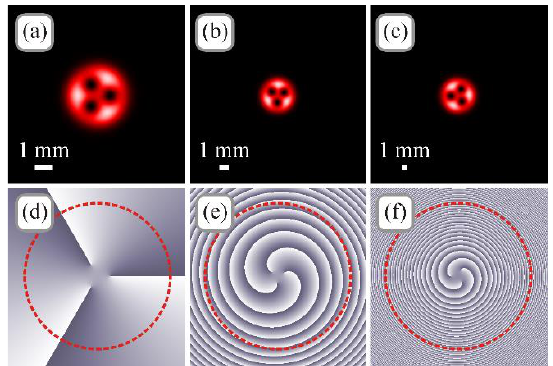
Figure 3. Intensity ( a – c ) and phase ( d – f ) distributions of a Gaussian beam with several vortices (Equation (19)) in several transverse planes for the following parameters: wavelength λ = 633 nm, waist radius w = 1 mm, number of vortices m = 3, radius of the circle with vortices r 0 = 0.7 w , propagation distances z = 0 ( a , d ), z = z 0 /2 ( b , e ), and z = 2 z 0 ( c , f ), calculation area − R ≤ x , y ≤ R with R = 5 mm ( a , d ), R = 10 mm ( b , e ), and R = 20 mm ( c , f ). Red circles on the phase distributions are those along which TC (Equation (2)) and invariants (Equations (16) and (17)) were